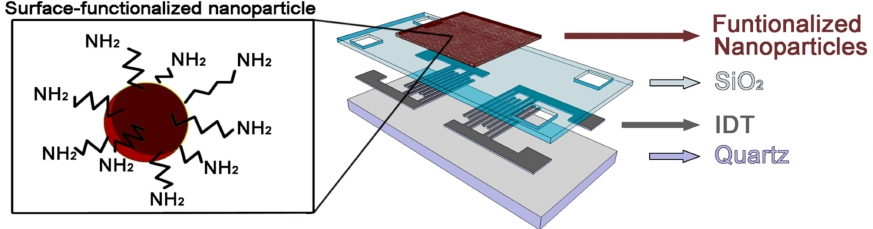
Figure 1. A 3D scheme representing a Love wave sensor with a functionalized nanoparticle sensitive layer. IDT: interdigital